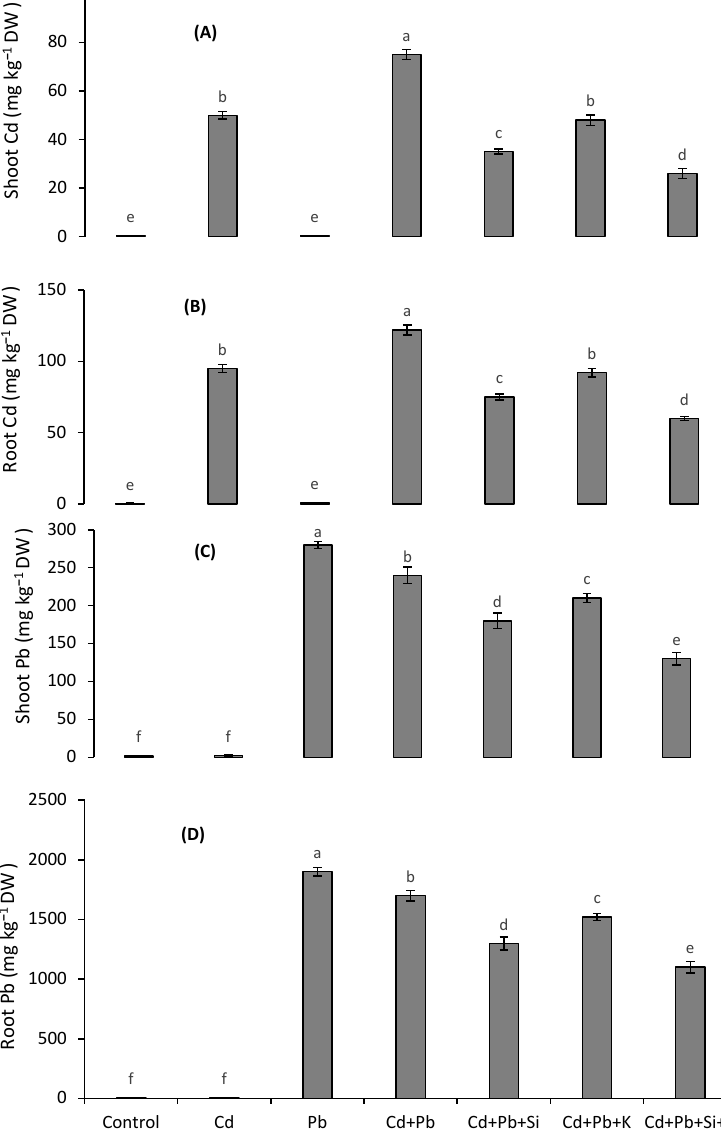
Figure 4. Effect of different Cd and Pb treatments on shoot Cd ( A ), root Cd ( B ) shoot Pb ( C ) and root Pb ( D ) concentrations in quinoa with and without supplementation with Si and K. Bars with different letters indicate the significant difference among the treatments at 5% significance level. Table 3. Bioconcentration factor (BCF), translocation factor (TF) and tolerance index (TI) of quinoa plants under Cd and Pb treatments with and without supplementation with Si and K. Treatment